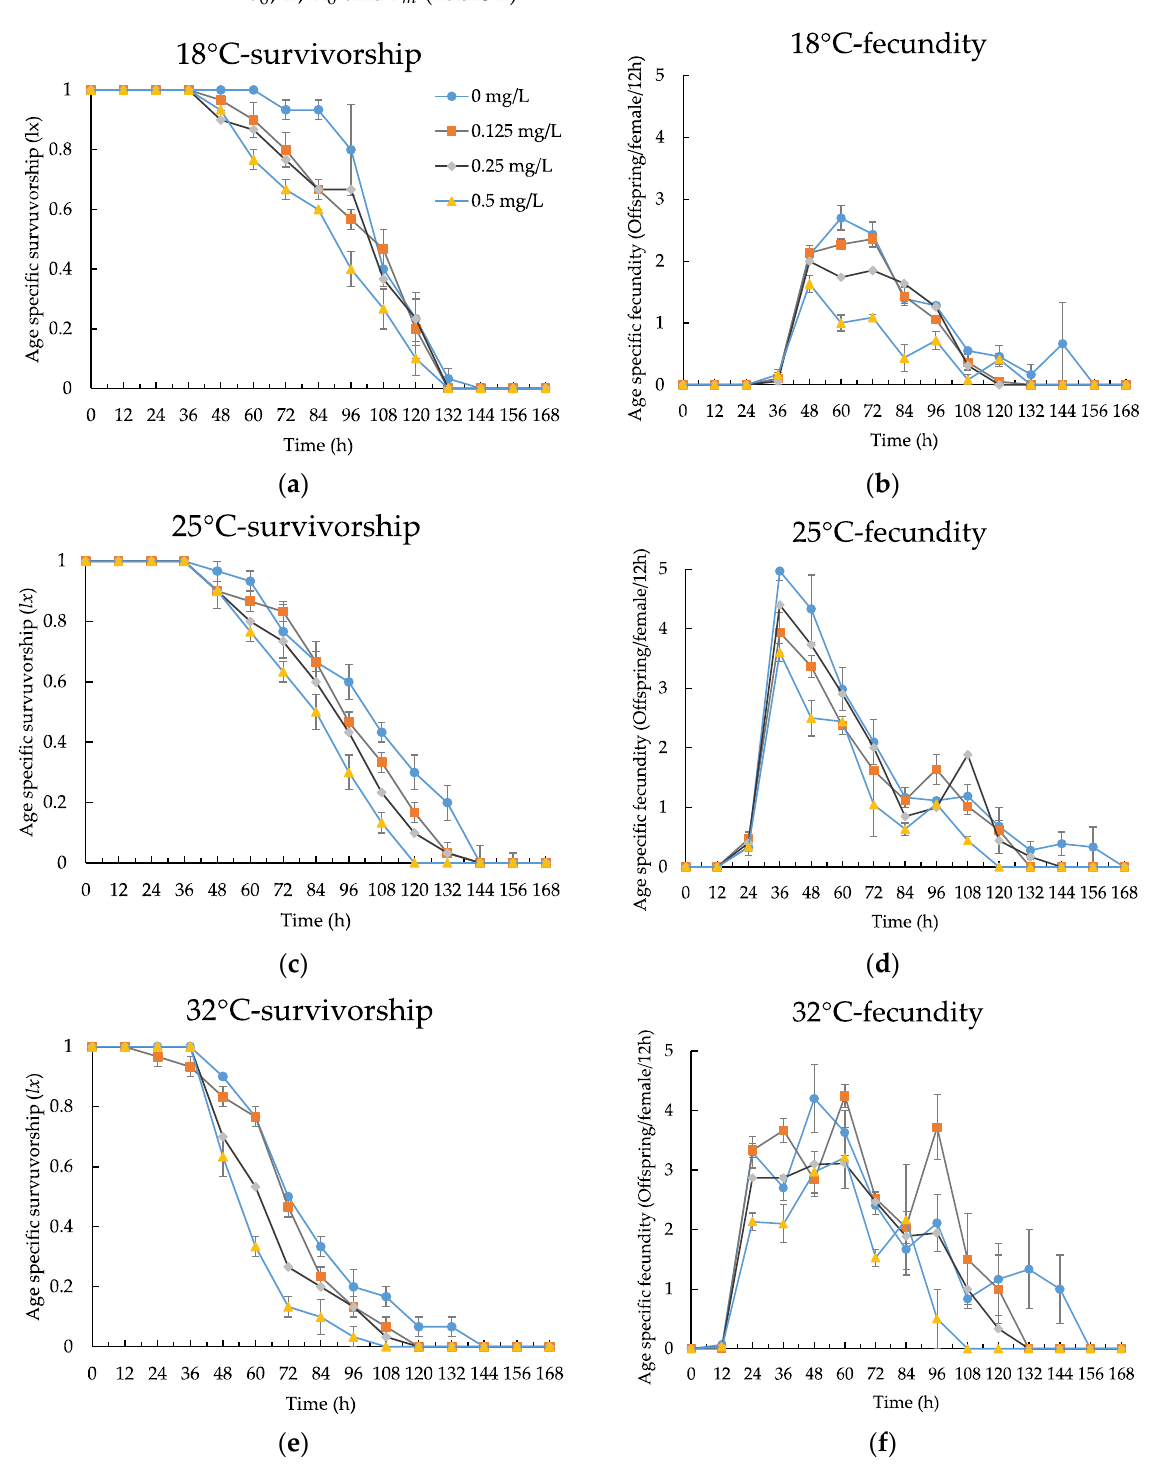
Figure 2. Age-specific survivorship and age-specific fecundity of B. calyciflorus exposed to different concentrations of chlorpromazine at different temperatures. Shown are the mean ± standard error based on three replicates for: ( a ) 18 °C—survivorship; ( b ) 18 °C—fecundity; ( c ) 25 °C—survivorship; ( d ) 25 °C—fecundity; ( e ) 32 °C—survivorship; ( f ) 32 °C—fecundity. Table 3. Effects of temperatures and chlorpromazine on the life history demographic parameters of B. calyciflorus . Shown are the mean ± standard error based on three replicates.